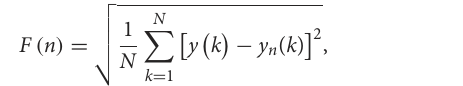
Algorithm 6. Power spectral density (Chakladar and Chakraborty,